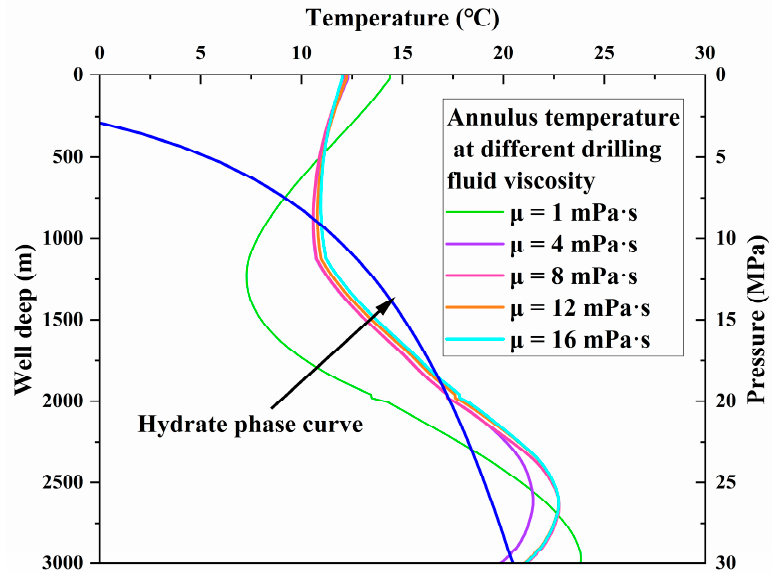
Figure 3. Risk of gas hydrate formation under different drilling fluid viscosity.